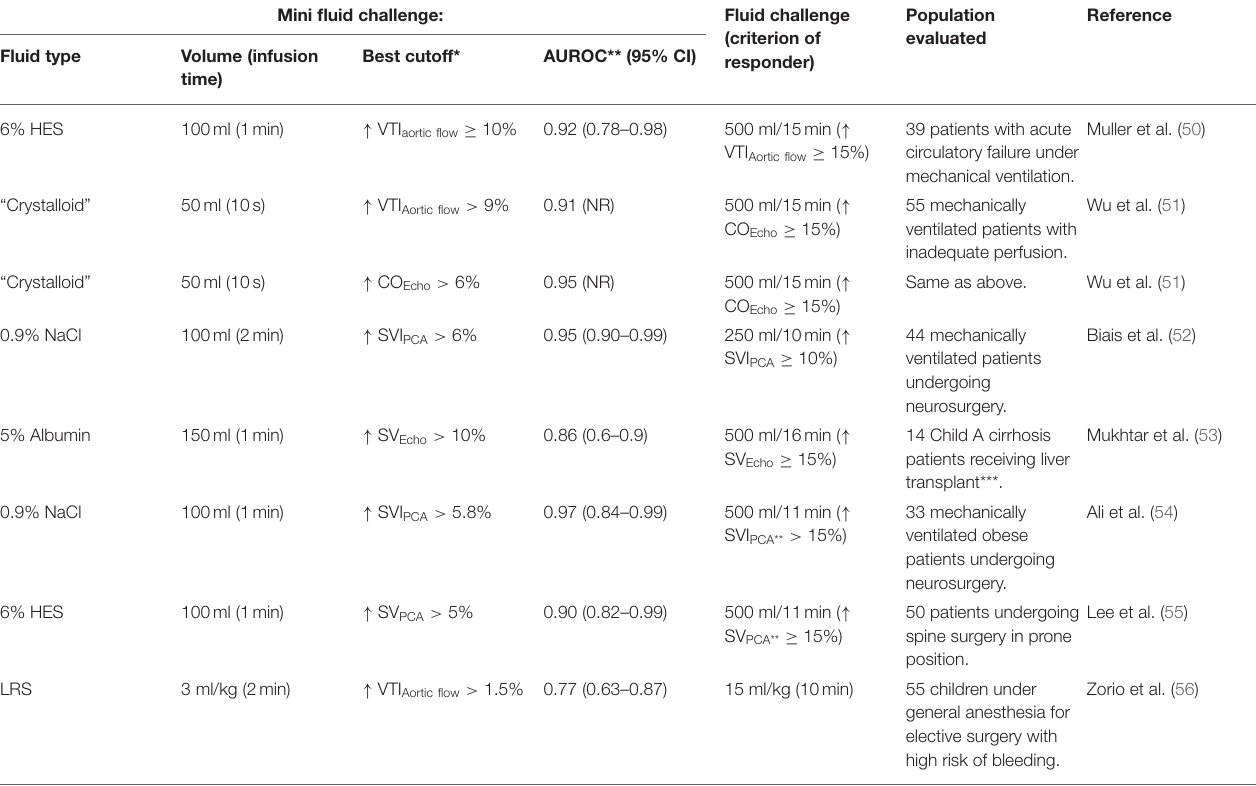
TABLE 1 | Clinical studies using a mini-fluid challenge to predict the response to a standard fluid challenge in humans. Mini fluid